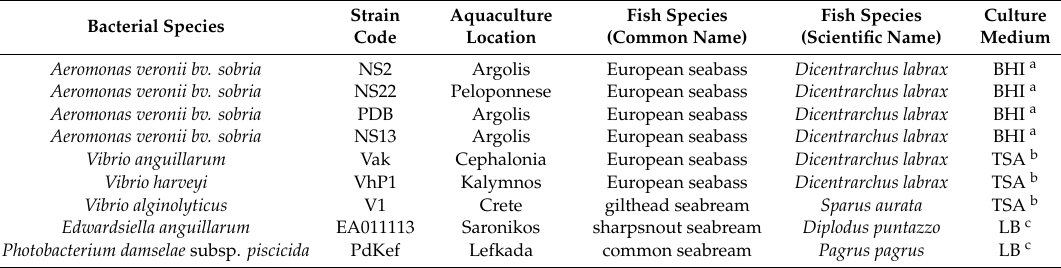
Table 5. Bacterial fish pathogens isolated from Greek aquaculture facilities. Strain Bacterial Species